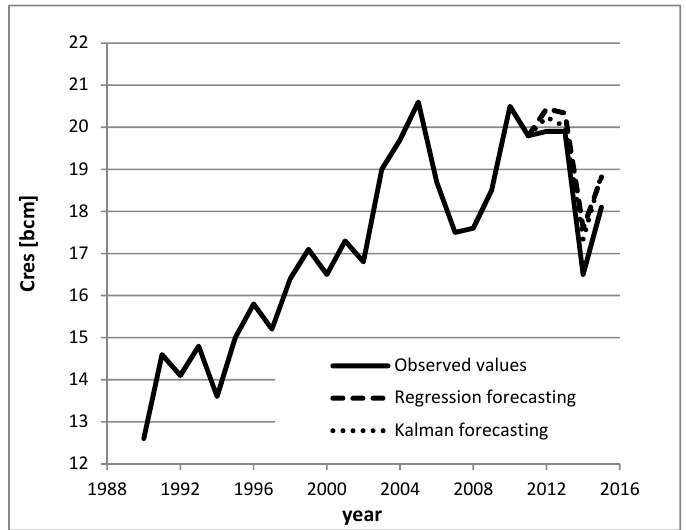
Figure 1. Validation phase. C res values. Observer data in the period 1990–2011 (continuous line) and forecasted values in the years 2012–2015; Regression algorithm (dashed line) and Kalman algorithm (dotted line).